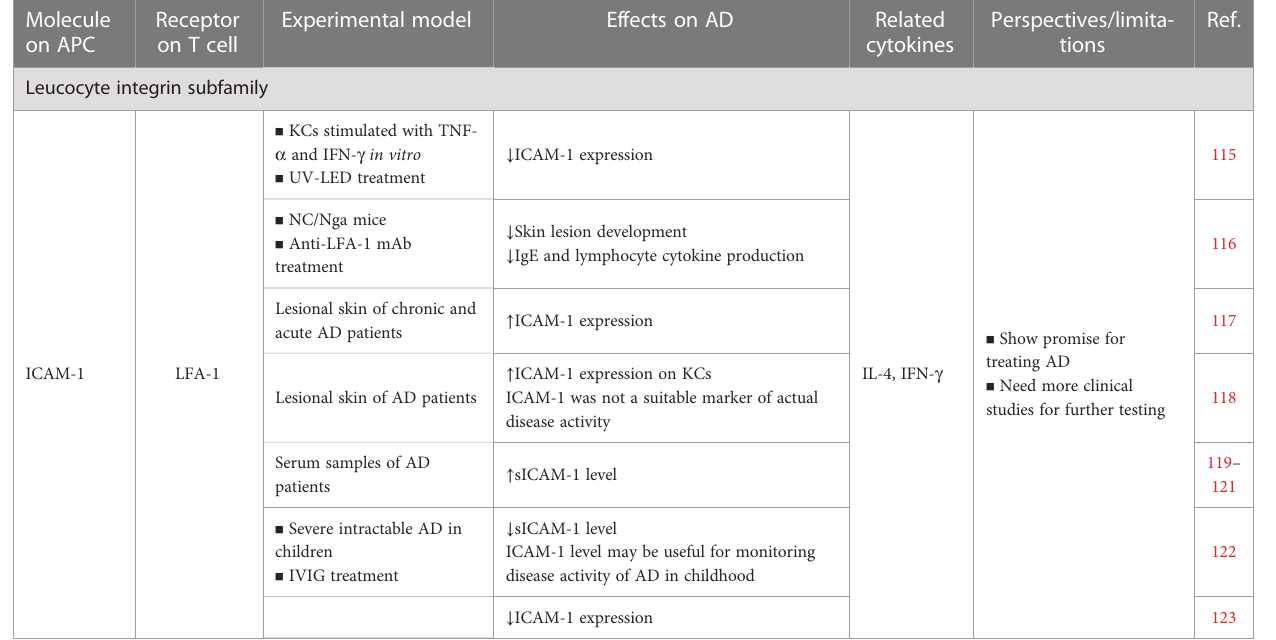
Perspectives/limita- cytokines tions